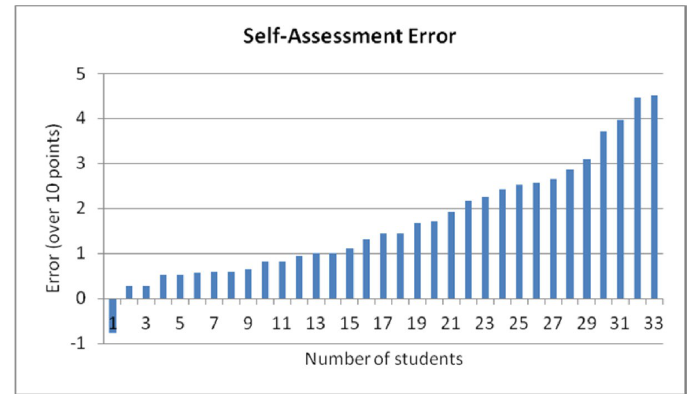
Figure 4. Self-assessment error